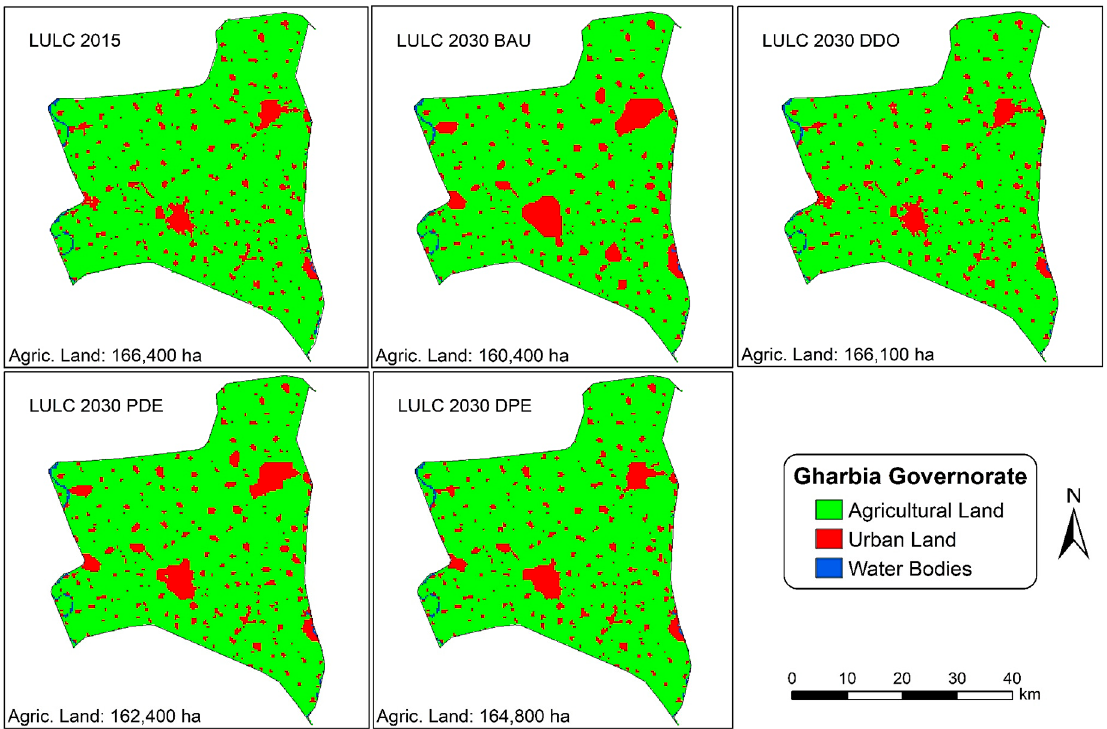
Figure A6. Amount of agricultural land over Gharbia governorate within the simulated scenarios relative to the state in 2015